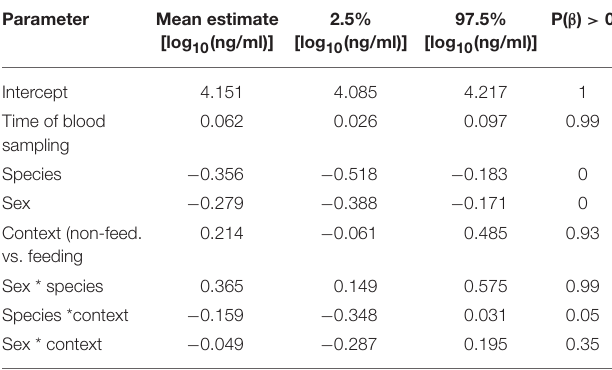
TABLE 1 | Estimates of effect sizes and the 95% credible intervals of the posterior distribution of baseline corticosterone concentrations. Parameter